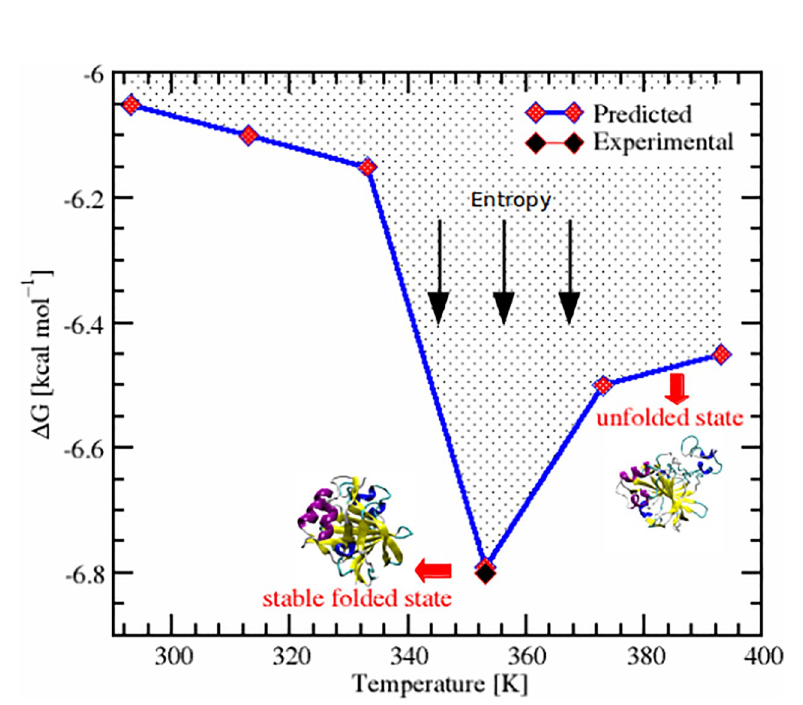
Fig 8. Energy landscape of SazCA. Funnel shaped energy landscape of SazCA representing the relationship of folding/unfolding to the free energy as a function of temperature. The native-like structure found at 353 K is shown in secondary structure representation as the stable folded